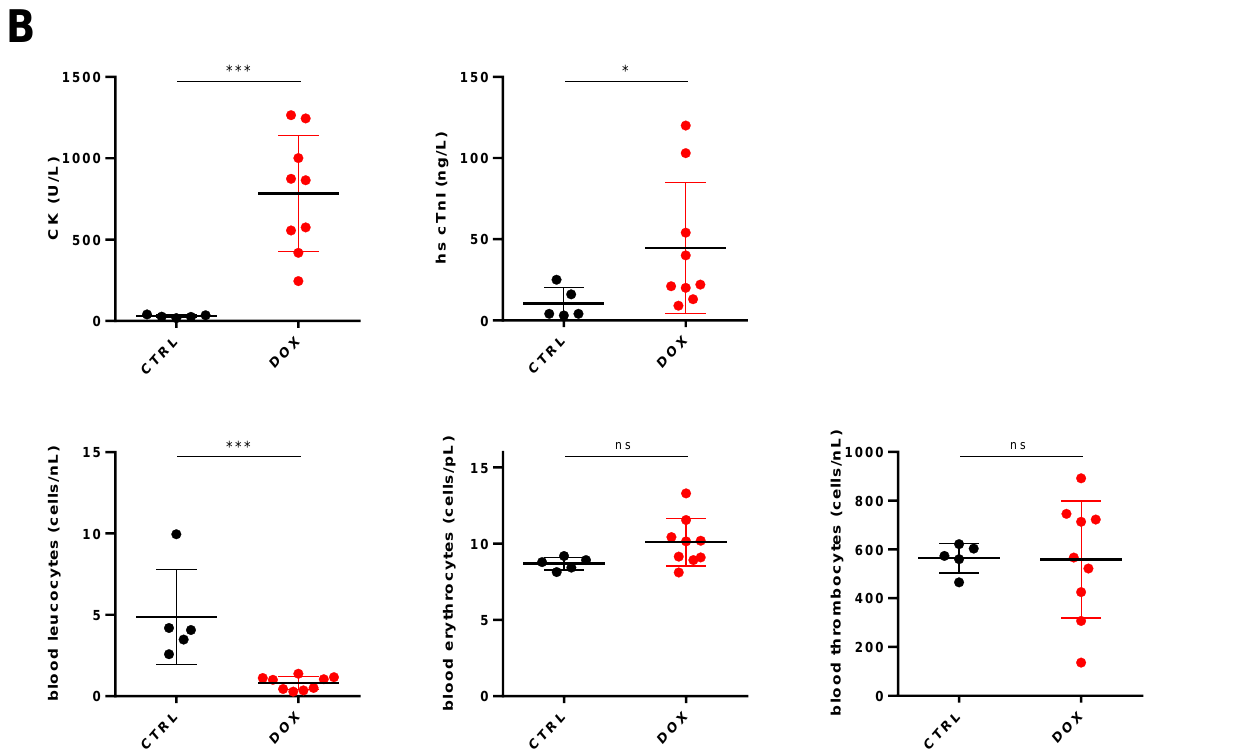
Figure 2. Effects of Doxorubicin treatment on heart function and blood parameters. ( A ) Top Ex- emplary M-mode echocardiograms from parasternal short axis views of the mouse heart of both the control (CTRL) and Doxorubicin (DOX) group before (d0) and after treatment (d6). Bottom Comparison of heart rate in isoflurane narcosis, as well as left ventricular ejection fraction (EF) and fractional shortening (FS) of CTRL and DOX treated animals (n = 5–8, ANOVA with Bonferroni post- hoc test, *: p < 0.05). ( B ) Top Levels of creatine kinase (CK) and highly sensitive cardiac troponin I (hscTnI) from control and doxorubicin treated animals at day 6 after beginning of experiment (n = 5–9, Student’s t -test with Welch correction, *: p < 0.05, ***: p < 0.001). Bottom Number of leucocytes, erythrocytes and thrombocytes present in the blood of CTRL and DOX groups at day 6 after